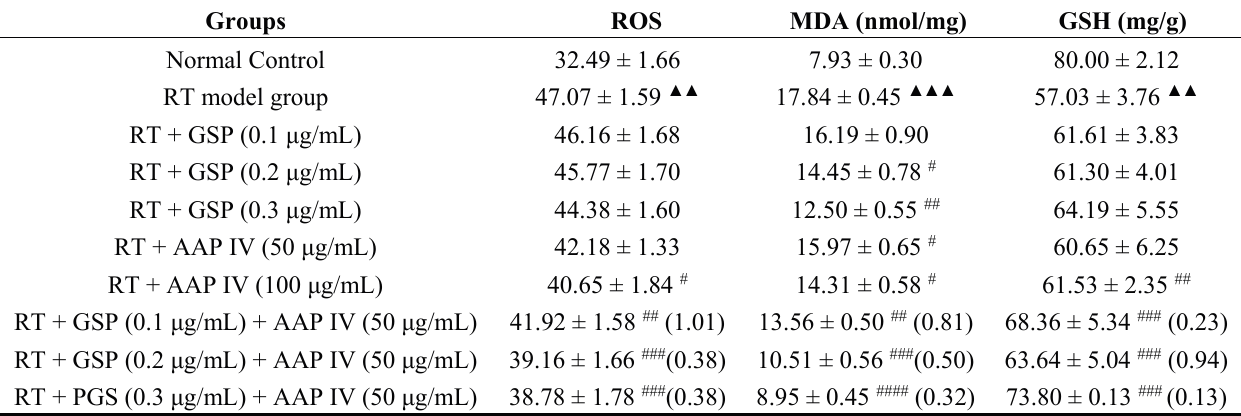
Table 3. Effects of GSP, AAP IV, and their combination on splenocytes product level. Values represent the mean and standard deviation of at least three independent